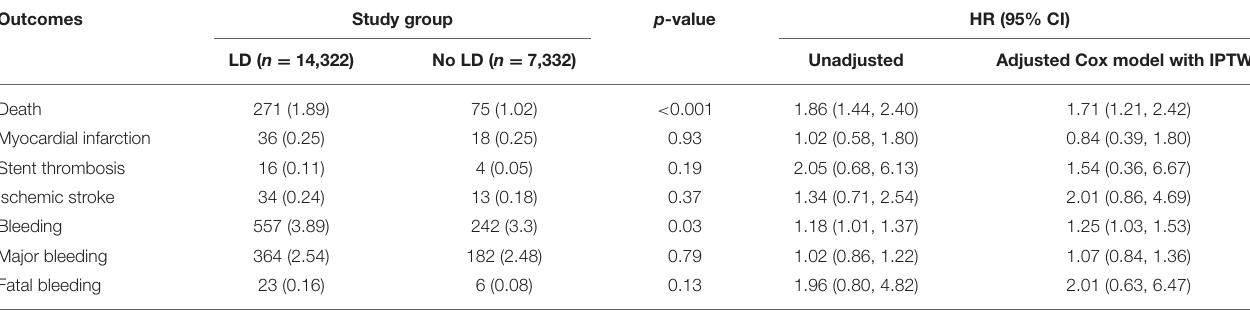
TABLE 2 | Incidence of in-hospital clinical outcomes, and risk of LD treatment. Outcomes